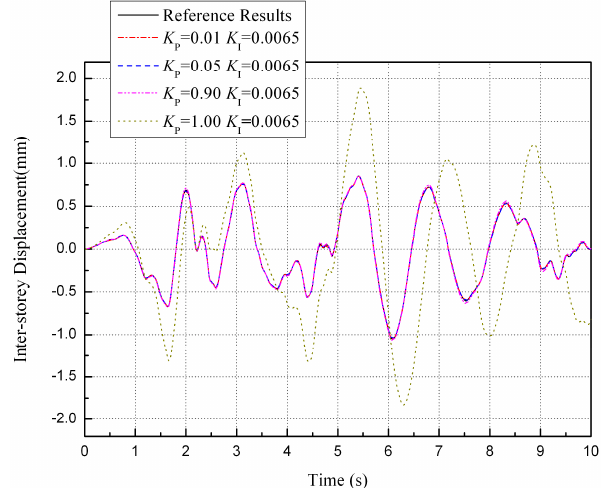
Figure 16. Time history curves of story drift with different proportional gains.